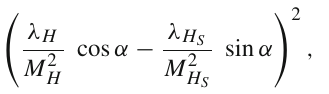
introduced heavy fermion, χ in the t -channel. Notice that, in the absence of χ the annihilation is enabled through the s - channel process, H 0 H 0 → ( H , H S ) → f SM fermion. The cross section of this process is proportional